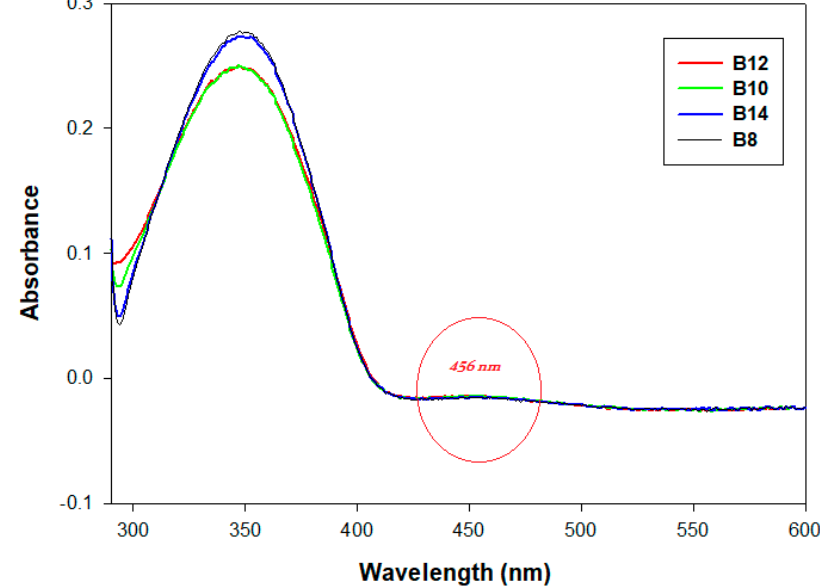
Figure 7. UV absorption spectrum of Bn derivatives in chloroform.